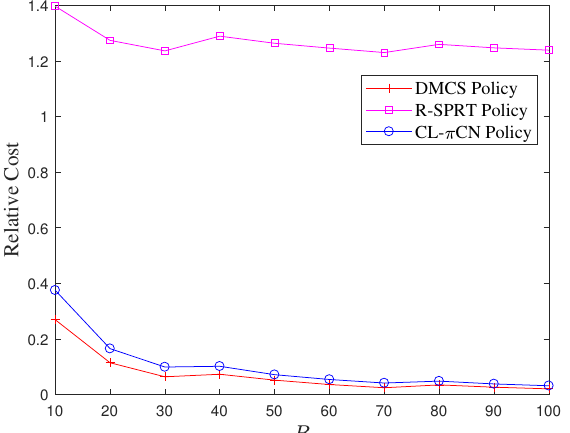
Figure 3. Performance comparison for M = 5, L = 2, s / B = 2 α , λ f = 1, λ g = 3.